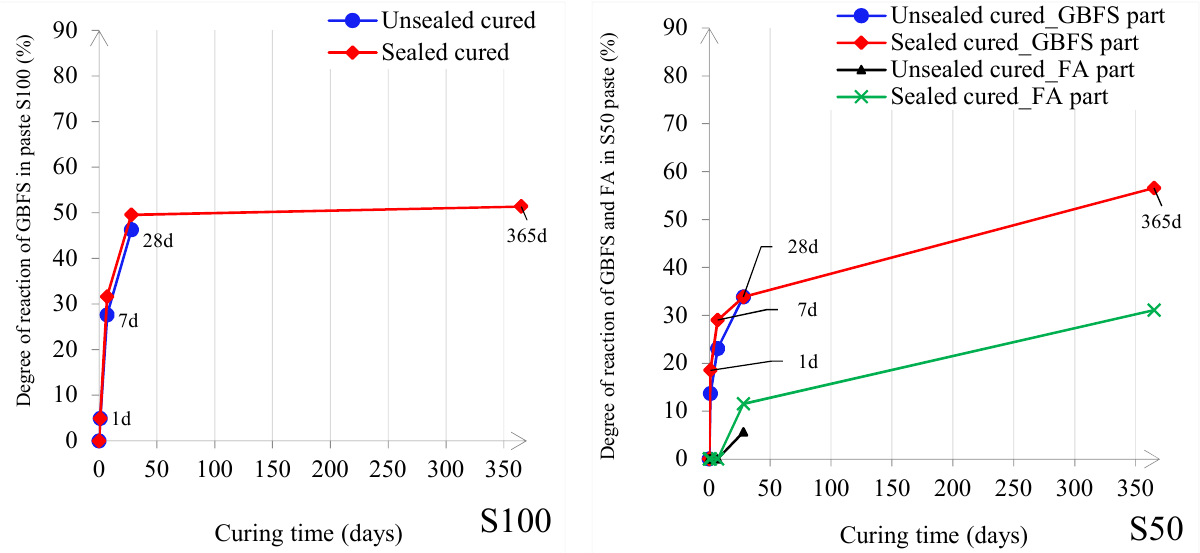
Figure 22. Degree of reaction of paste S100 ( left ) and paste S50 ( right ).